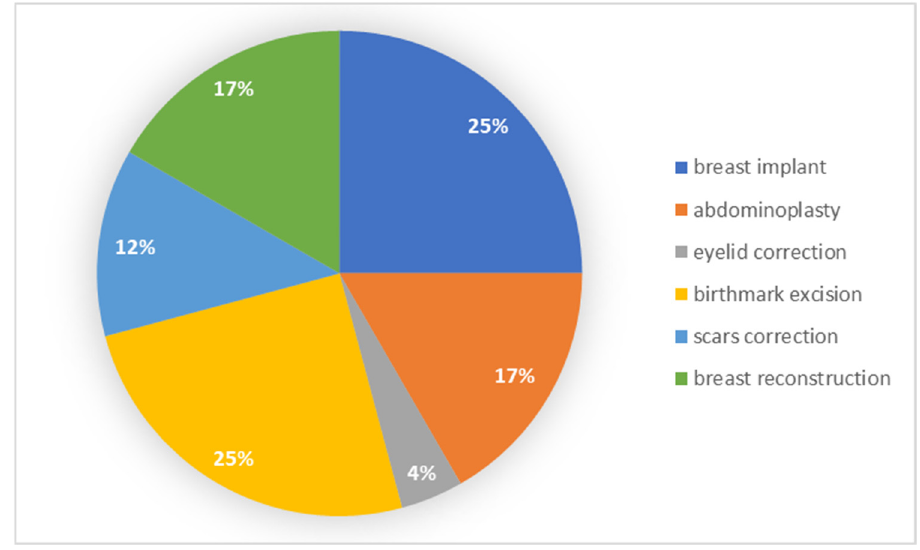
Figure 4. Types of procedures performed by patients with post-secondary education.